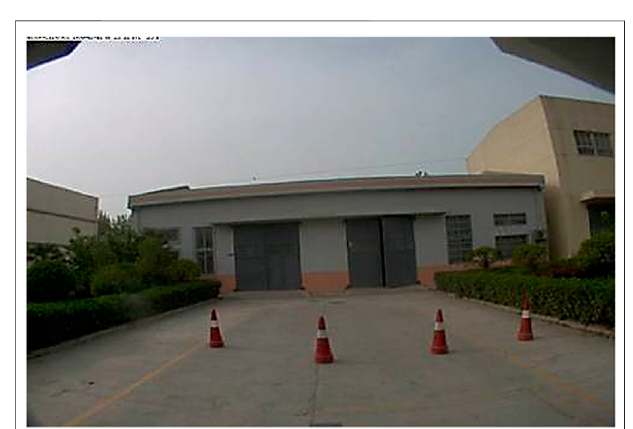
FIGURE 7 | Collected raw